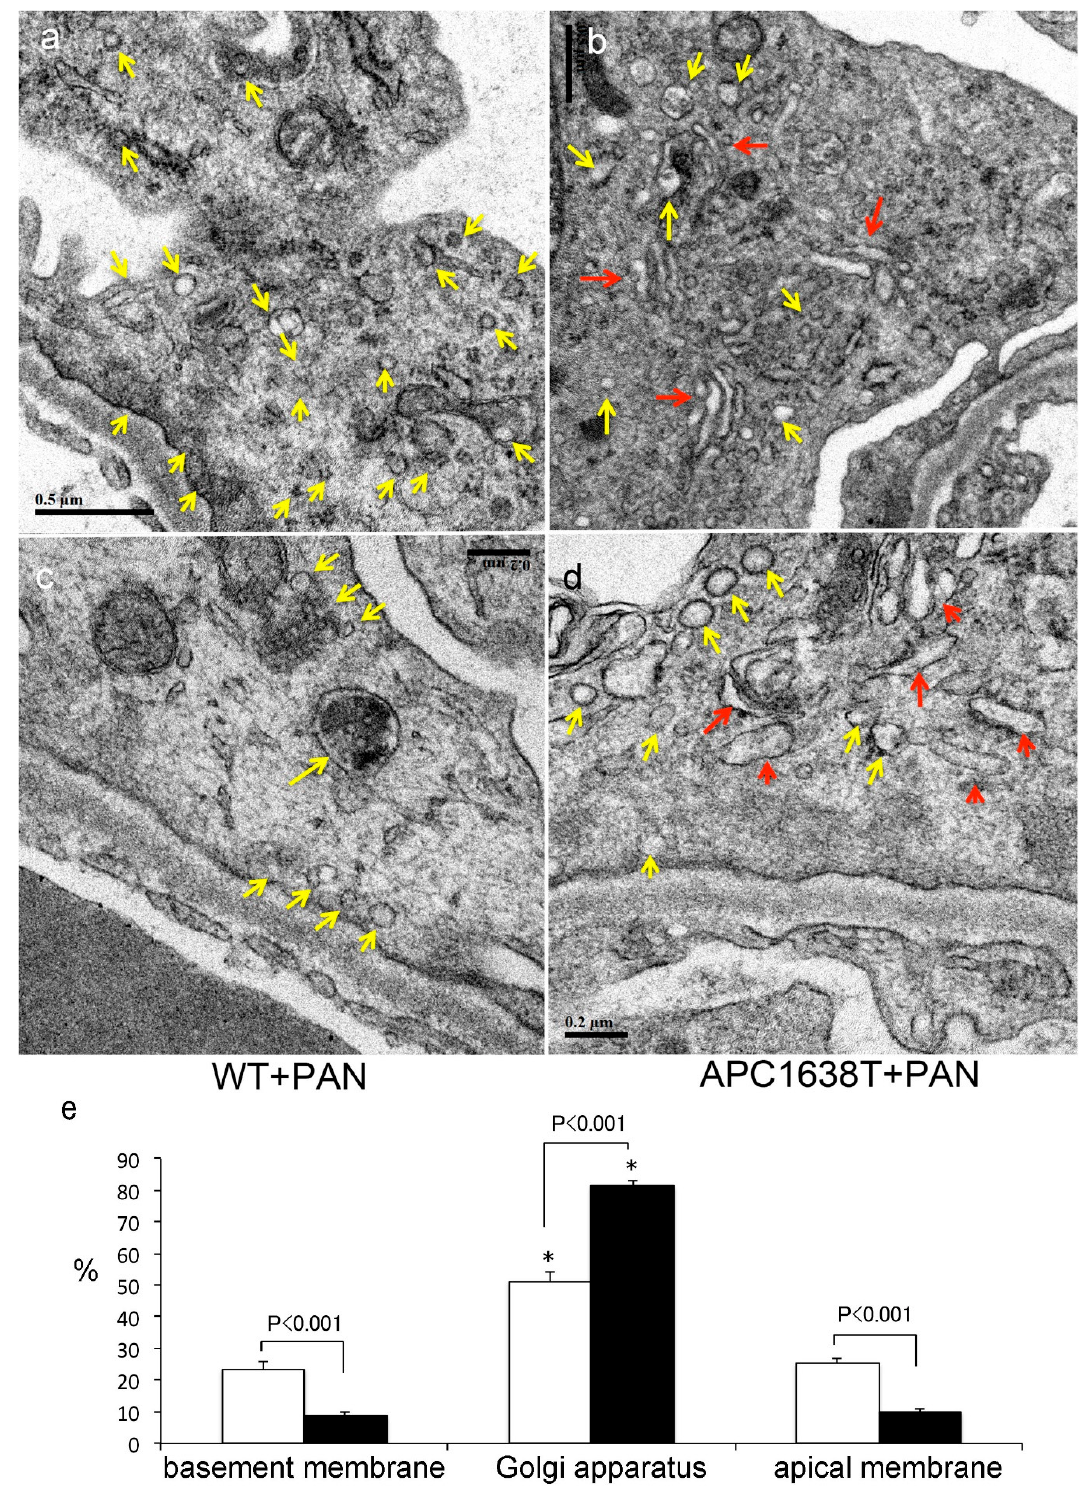
Figure 5. Electron micrograph ( a – d ) of podocyte and percent vesicle distribution ( e ) around the basement membrane, Golgi apparatus, and apical membrane of PAN-induced nephrotic syndrome in the wild-type mice (WT+PAN, white bar) and APC1638T mice (APC1638T+PAN, black bar). The yellow arrows indicate endocytosis and transcytosis vesicles, and the red arrows tubular structures related to Golgi apparatus. The bar indicates 0.5 µ m ( a , b ) and 0.2 µ m ( c , d ). n = 25 podocytes from 3 WT+PAN mice and n = 32 podocytes from 3 APC1638T+PAN mice. * p < 0.001 vs. basement membrane in each